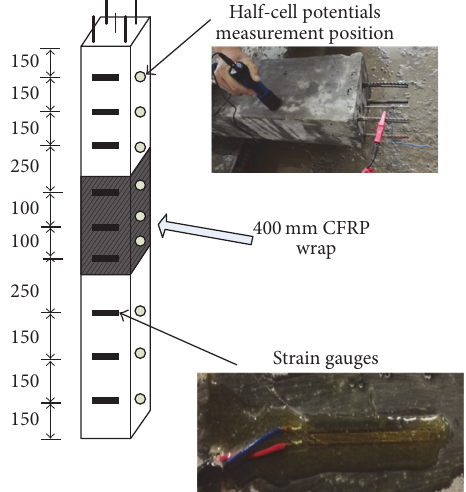
Figure 2: CFRP strengthening scheme and the measuring points (mm).